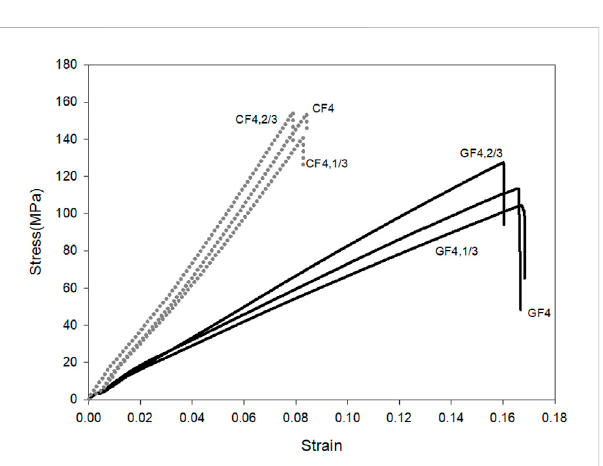
FIGURE 11 Stress-Strain curve according to the position of 4-layer